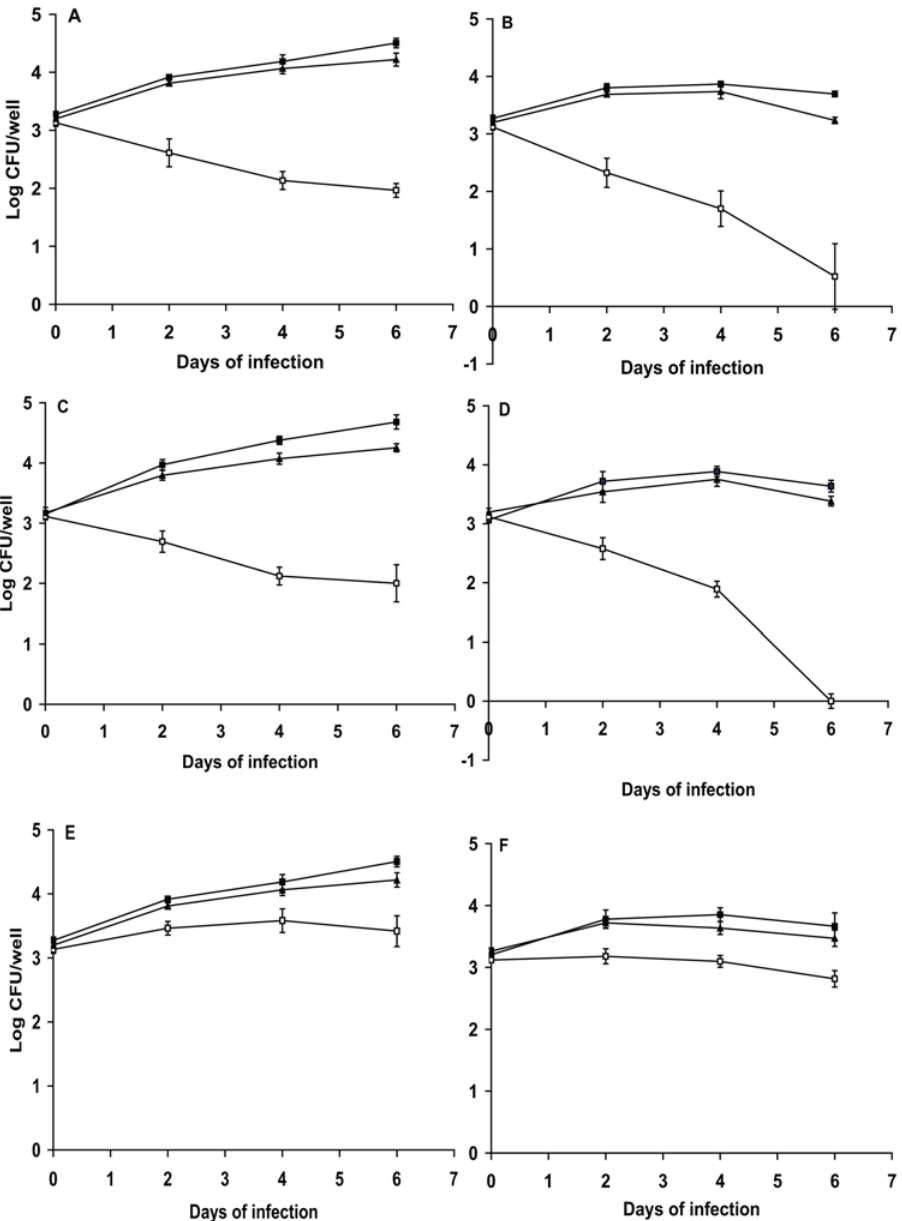
Figure 5. Growth and survival of M.tuberculosis D tpx in resting and IFN- c -activated macrophages. A. Infection in resting bone marrow derived macrophages from BALB/c mice. B. Infection in IFN c activated bone marrow derived macrophages from BALB/c mice. These results are the means and standard deviation derived from one representative of three independent experiments. C. Infection in resting bone marrow derived macrophages from C57BL/6 mice. D. Infection in IFN c activated bone marrow derived macrophages from C57BL/6 mice. E. Infection in resting bone marrow derived macrophages from iNOS KO mice. F. Infection in IFN c activated bone marrow derived macrophages from iNOS KO mice. The results are the means and SDs derived from triplicate wells. The experiments have been reproductively repeated once. Solid square: WT M. tuberculosis H37Rv. Open square: YH D tpx. Solid triangle, YH tpx Comp.